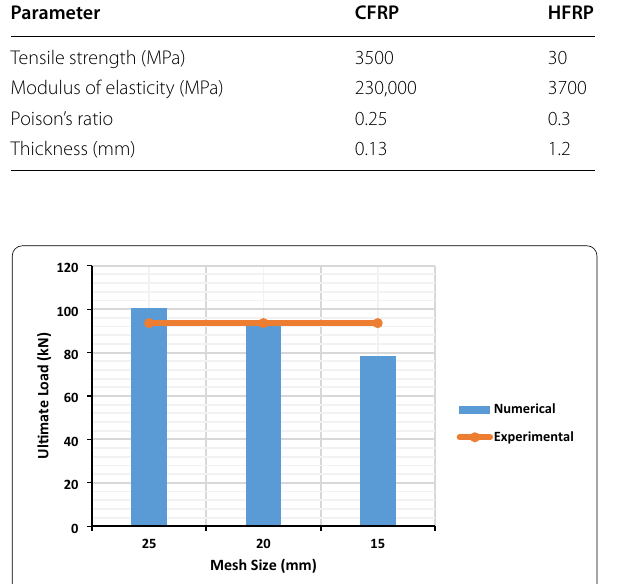
Fig. 16 Experimental versus numerical results for different mesh sizes.